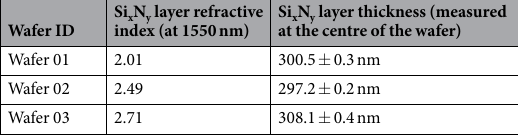
Table 1. Wafer description and